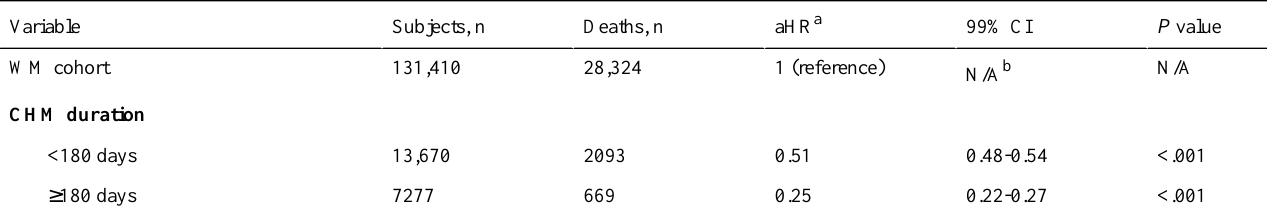
Table 2. Association of Chinese herbal medicine for diabetic kidney disease with lower mortality probability.